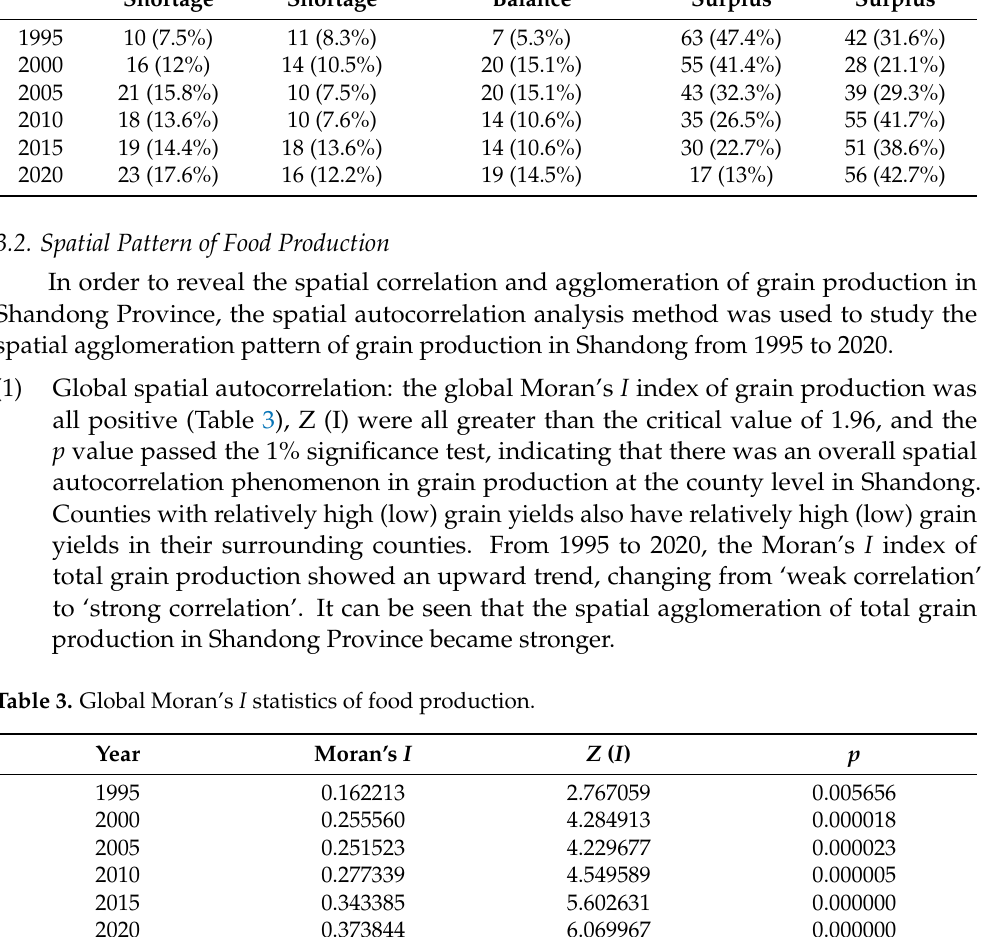
Table 2. Shandong county-level per capita grain supply from 1995 to 2020. Number of Shandong Counties (%) (Missing Data Are Not Included in the Calculation) Year